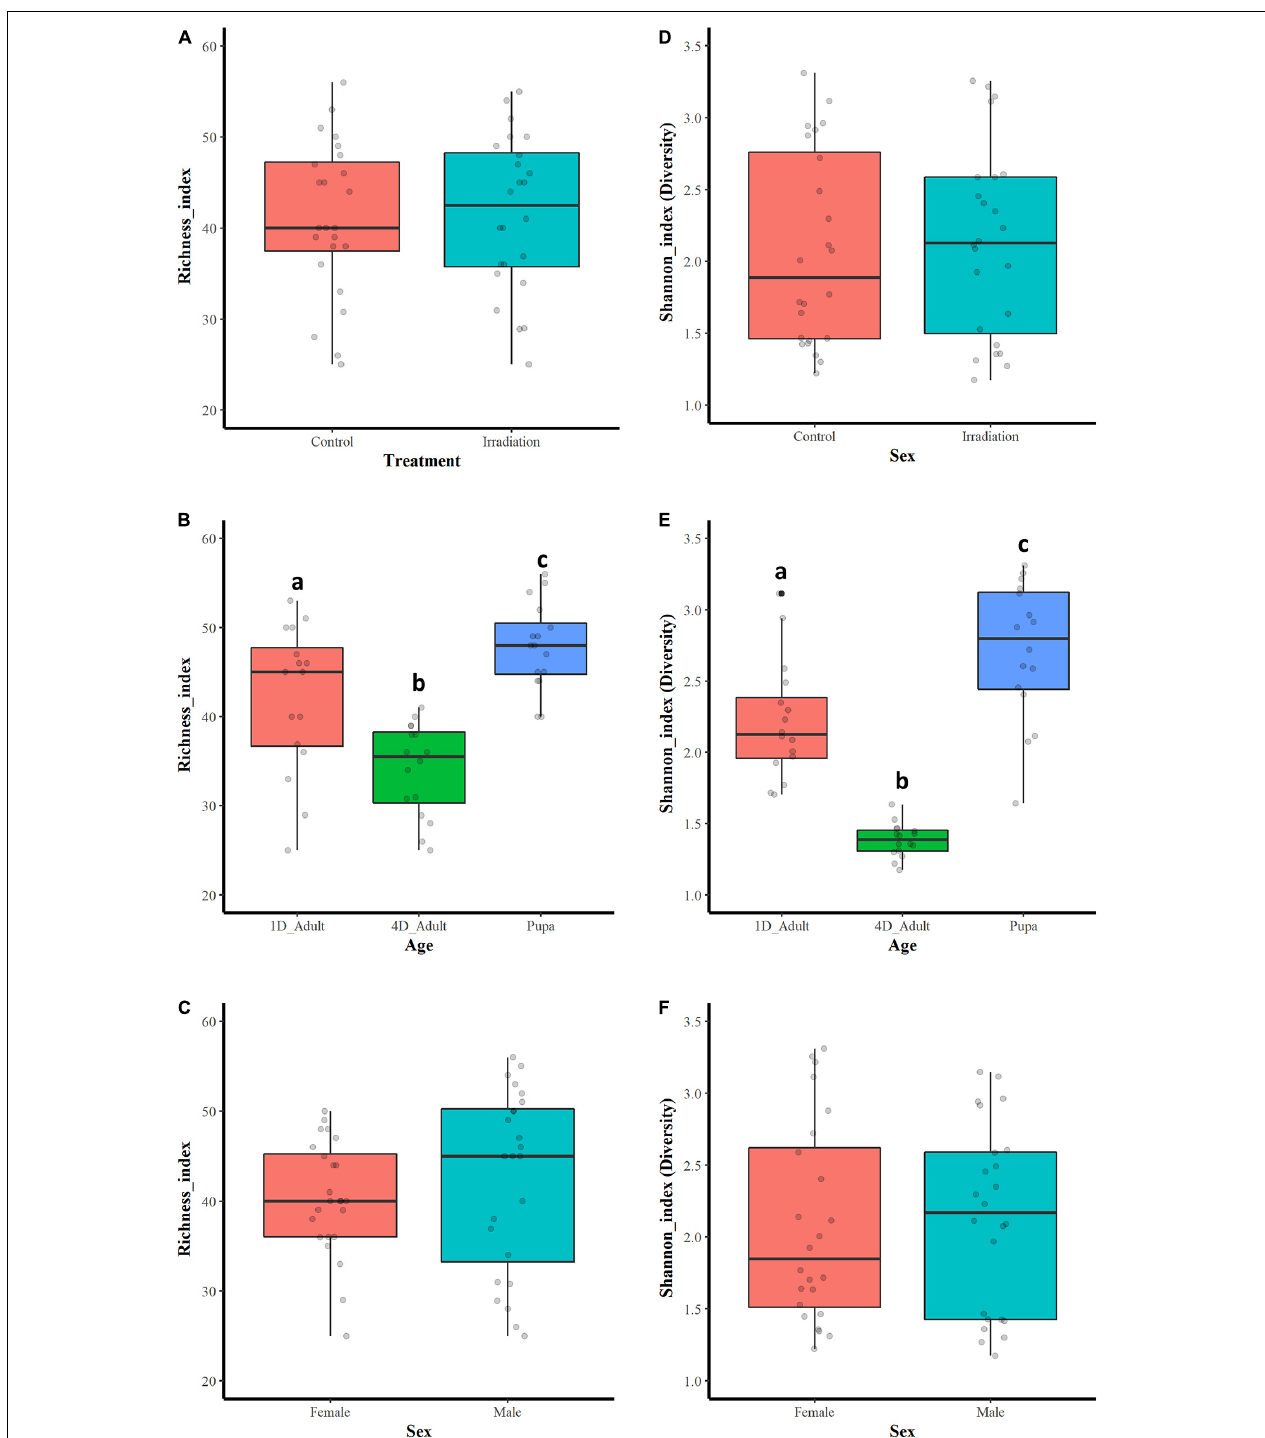
FIGURE 1 | Bacterial community richness and diversity based on the Species richness and Shannon indices. Bacterial richness (A) and diversity (D) of guts between irradiated and non-irradiated samples. Bacterial richness (B) and diversity (E) of guts from pupa, 1- and 4-day-old adults. Bacterial richness (C) and diversity (F) of guts between male and female mosquitoes. Boxes extend between the 25th and 75th percentile. A thick line denotes the median. The whiskers extend up to the most extreme values. The gray circles indicate the number of data points used in each plot. Two-tailed Mann-Whitney U -test was used to compare the bacterial richness and diversity indices in treatment or sex groups. Kruskal-Wallis test and Dunn’s multiple comparisons test were used to compare the bacterial richness and diversity indices in age groups. Significant differences are indicated by different letters.